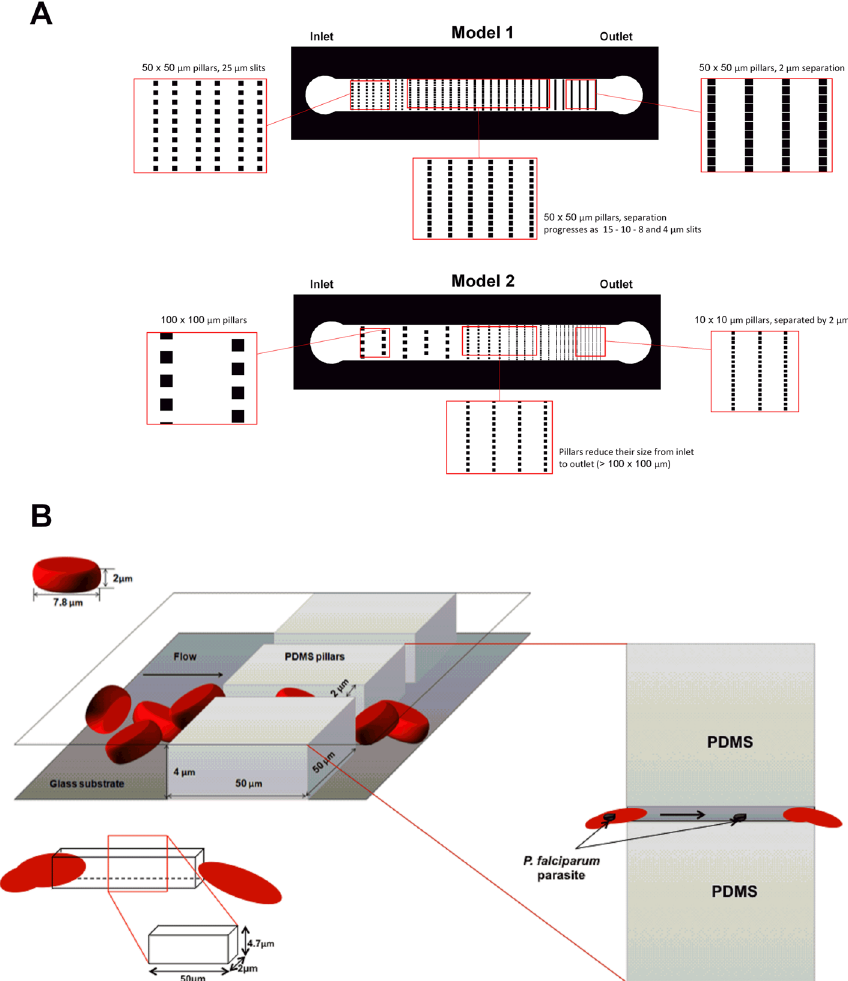
Figure 1. Microfluidic devices design for pitting studies. ( A ) Top: Device model 1. Single channel of 1 mm width × 8 mm length, with a filtration grid design of squared columns of 50 × 50 µm distributed along the channel, leaving a narrower space between them in each row (slits), from the inlet towards the outlet. Slits are 25, 15, 10, 8, 4, and 2 µm-wide, with a total of 100 slits progressively. Bottom: Device model 2. Single channel of 1 mm width × 8 mm length, with a filtration grid design of squared columns decreasing in size from 100 × 100 µm to 10 × 10 µm progressively, with a total of 498 slits. The space between columns in each row (slits) become narrower from the inlet towards the outlet, being the minimum slit size 2 µm-wide. ( B ) 3D representation of RBCs passing through 2 µm slits in the microfluidic channel. Inset shows the top view of the pitting process in which an infected RBC loses an intracellular parasite. P.f.- RBCs are depicted passing through a narrow path of 2 × 4.7 × 50 μm 3 . The design of the devices was made with Draftsight Software 2017 (Dassaults Systèmes) and the illustrations were created with power